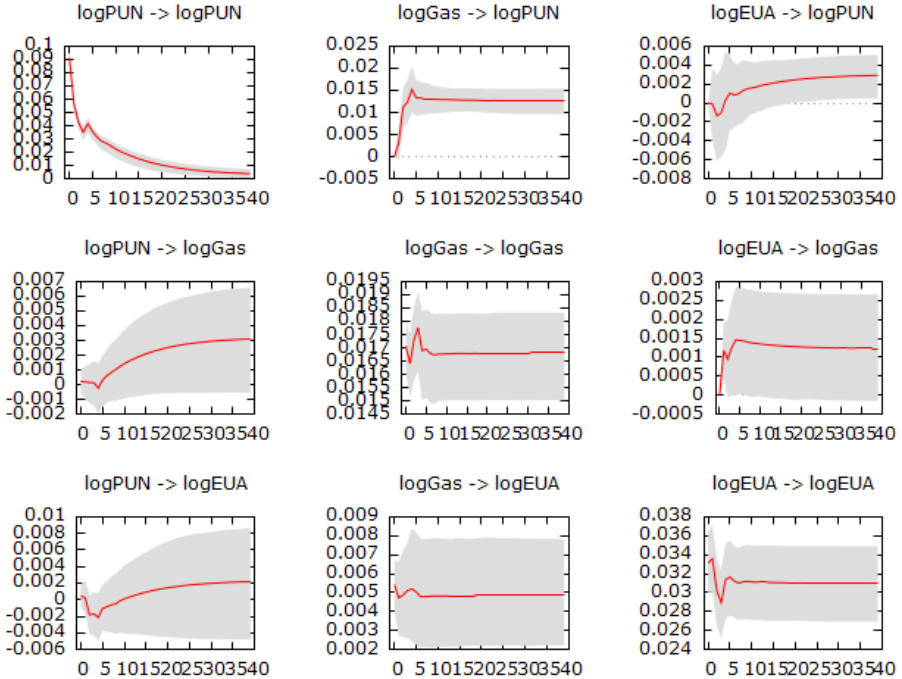
Figure 2. Impulse response functions of the VECM Model 1 (three variables, PUN, and one cointegration relation). The shaded area represents the 90% confidence interval.